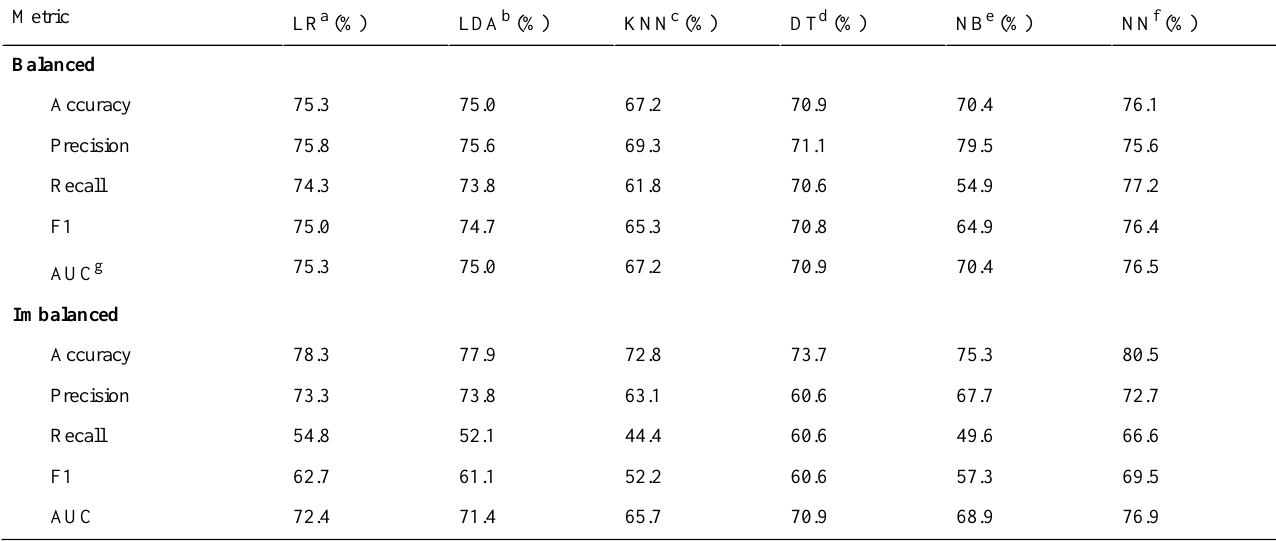
Table 6. Medical Information Mart for Intensive Care III classification performance in traditional